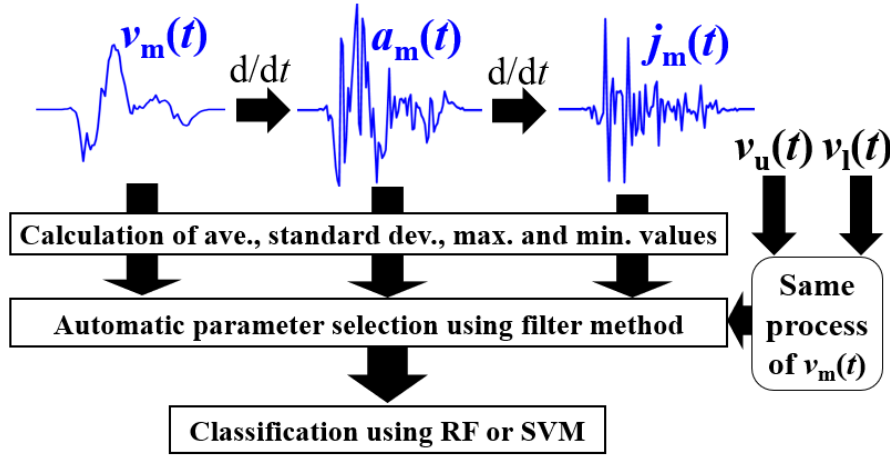
Figure 7. Outline of the RF and SVM methods using the motion parameters.